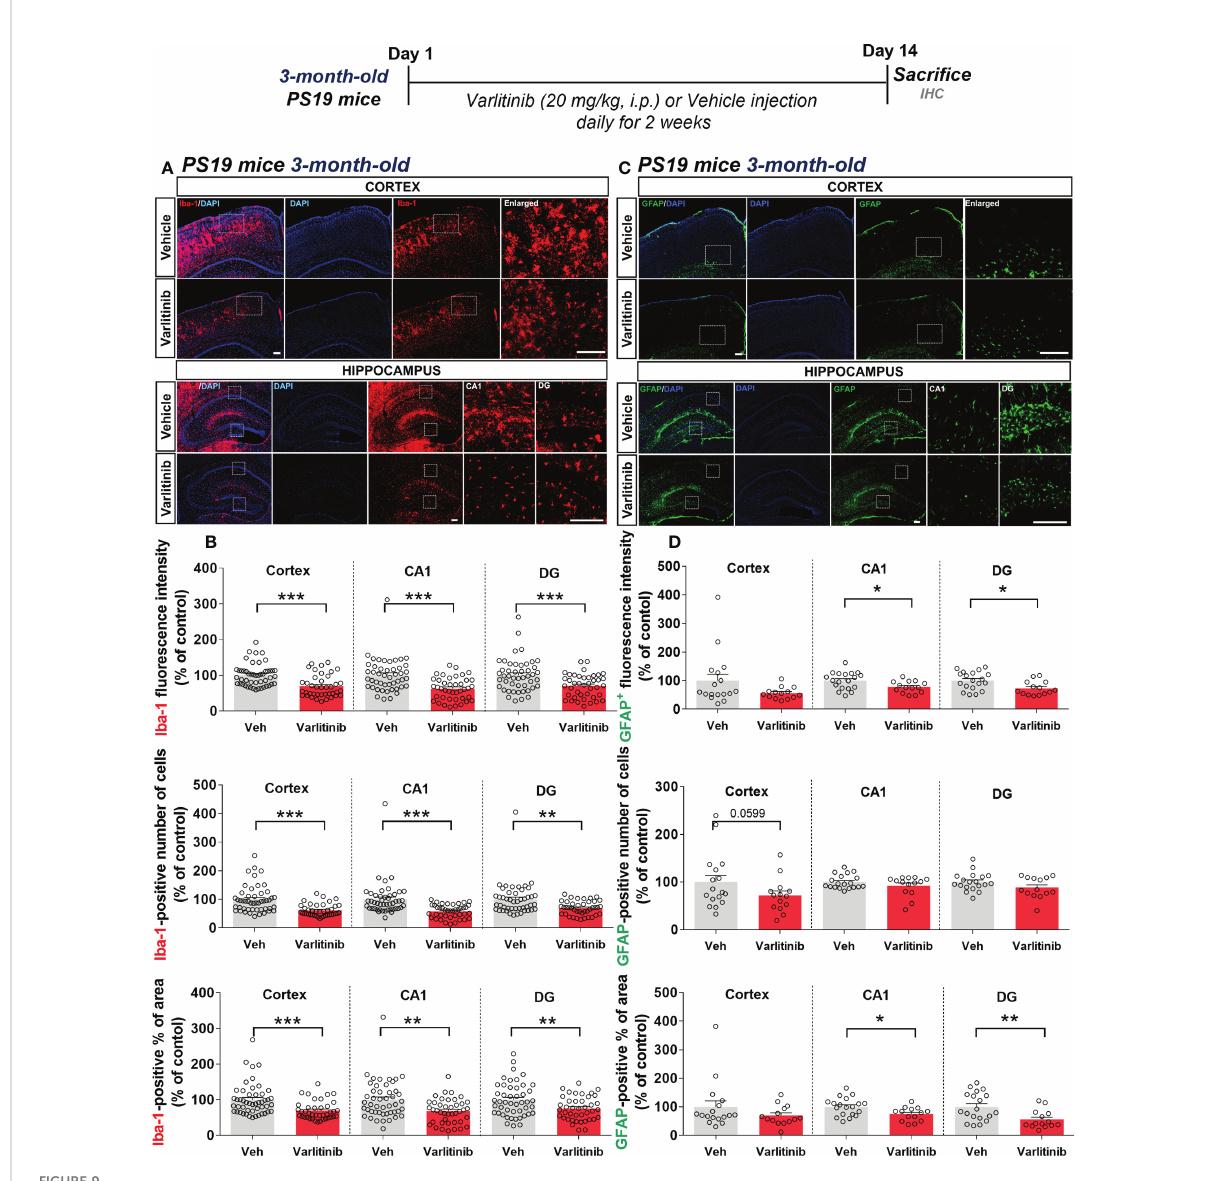
FIGURE 9 Varlitinib suppresses tau-mediated glial activation in 3-month-old tau-overexpressing PS19 mice. (A, C) Three-month-old tau-overexpressing PS19 mice were injected with varlitinib (20 mg/kg, i.p.) or vehicle (5% DMSO, 10% PEG, 20% Tween-80, i.p.) daily for 14 days, and immuno fl uorescence staining was carried out with anti-Iba-1 and anti-GFAP antibodies. (B, D) Quanti fi cation of data from A (n = 11